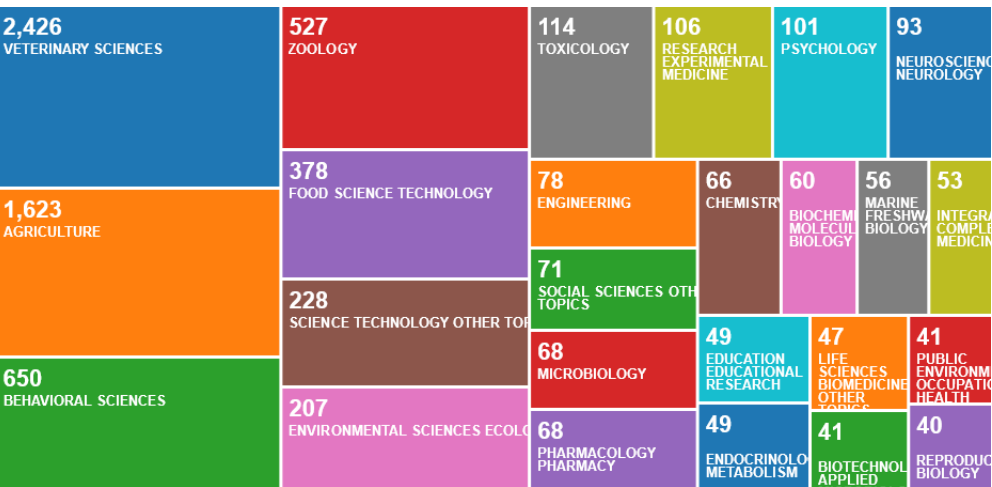
Figure 6. Number of publications per subject classification, according to an online survey of publications by animal welfare centres in the Web of Science, May 2020. The mean citations per item was 14, with a total of 67,957 citations (57,414 without self-citations) in 38,730 articles (36,078 without self-citations).